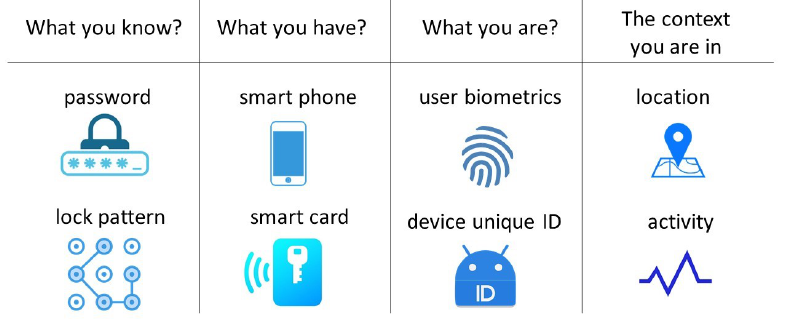
Figure 1. Some examples of factors that are used in multi-factor